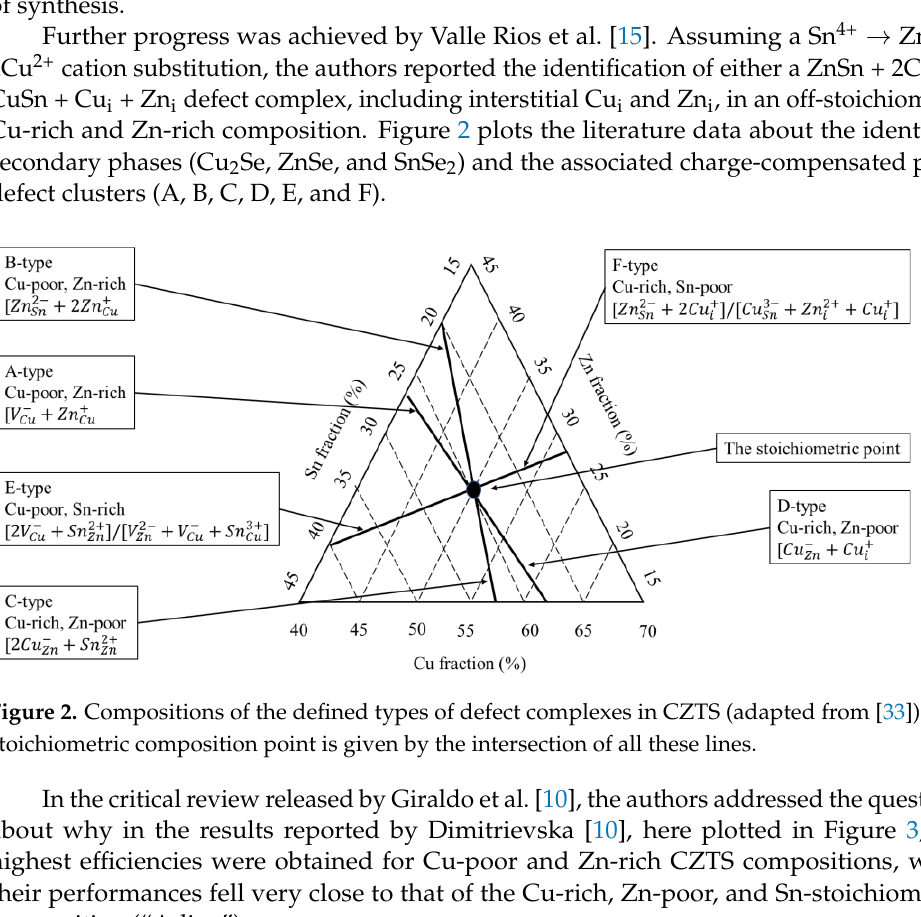
Figure 2. Compositions of the defined types of defect complexes in CZTS (adapted from [33]). The stoichiometric composition point is given by the intersection of all these lines.